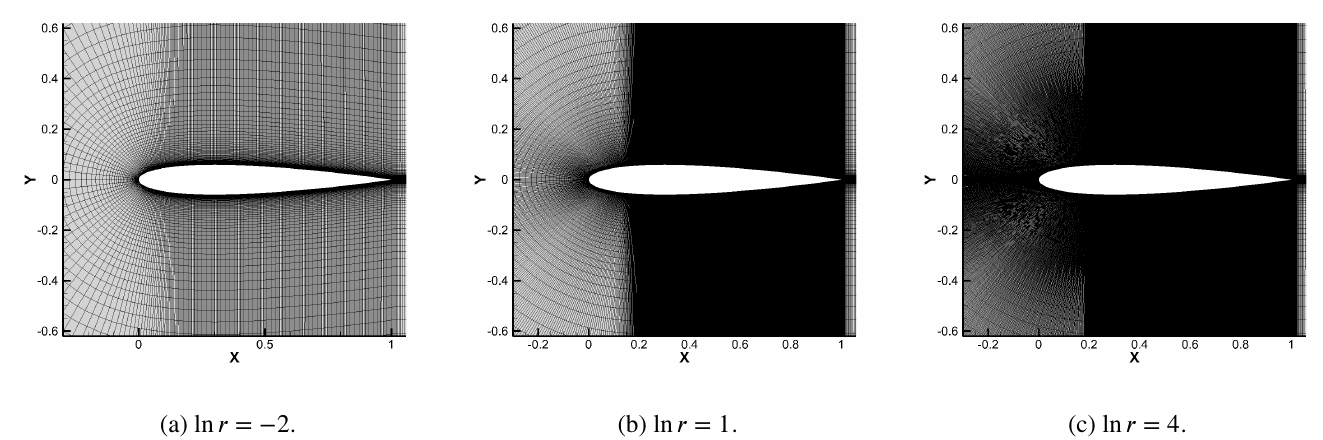
Figure 17. Cells around the rudder with varying chord-wise spacings for C-mesh. Table 8. Uncertainty estimations for C-mesh (log wise spacings based on mesh